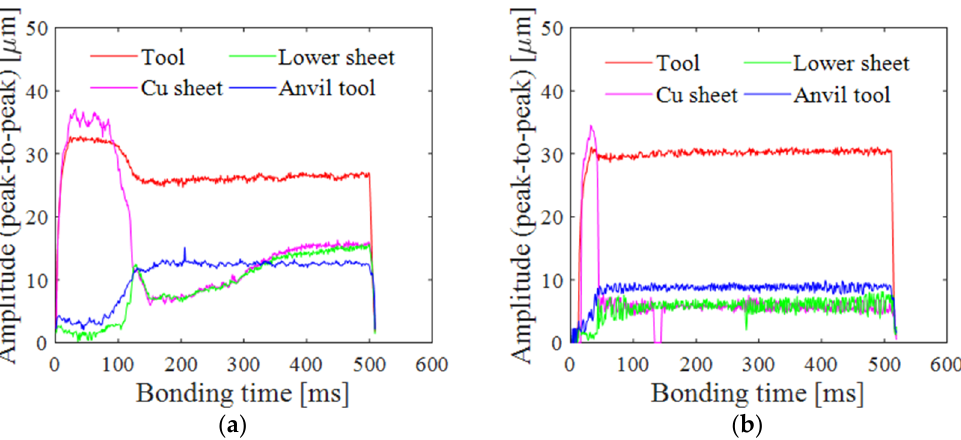
Figure 11. Amplitude of tools and specimens when ( a ) using the K-type tool and ( b ) C-type tool.